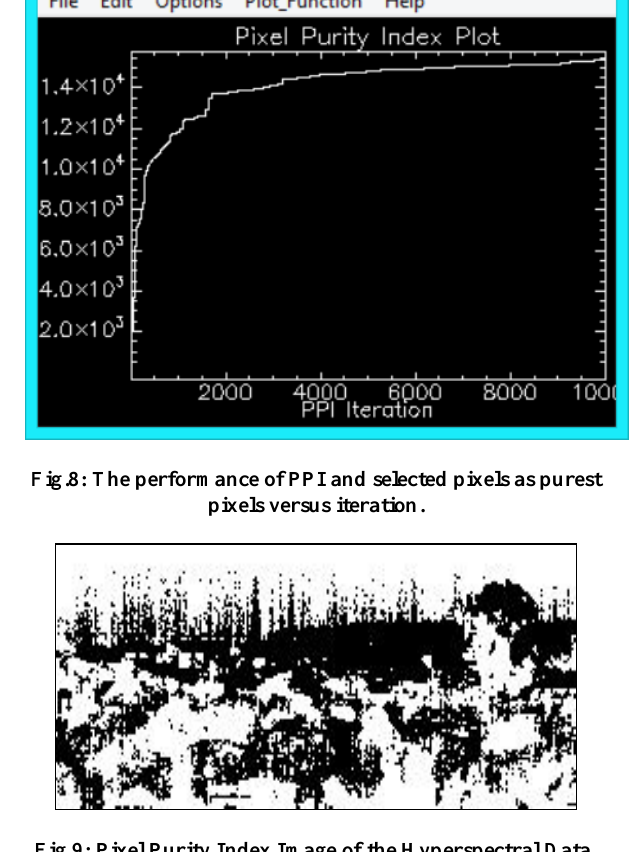
Fig.9: Pixel Purity Index Image of the Hyperspectral